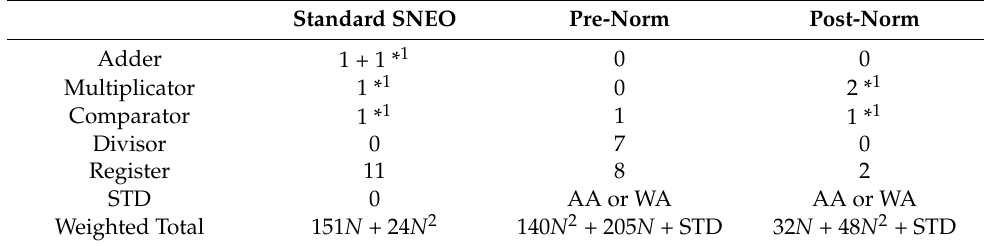
Table 6. Additional resources to build up each detector.